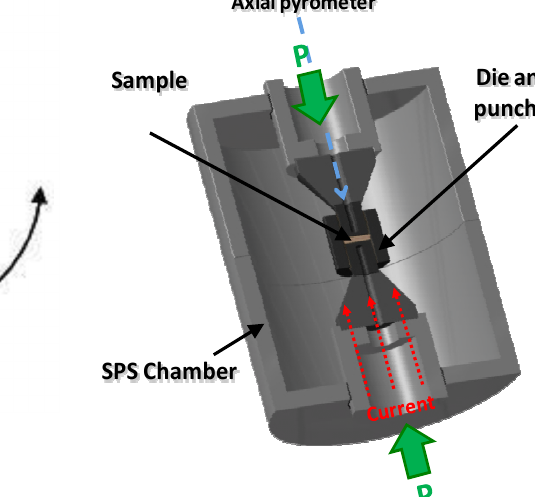
Fig. 2. Spark Plasma Sintering Technique